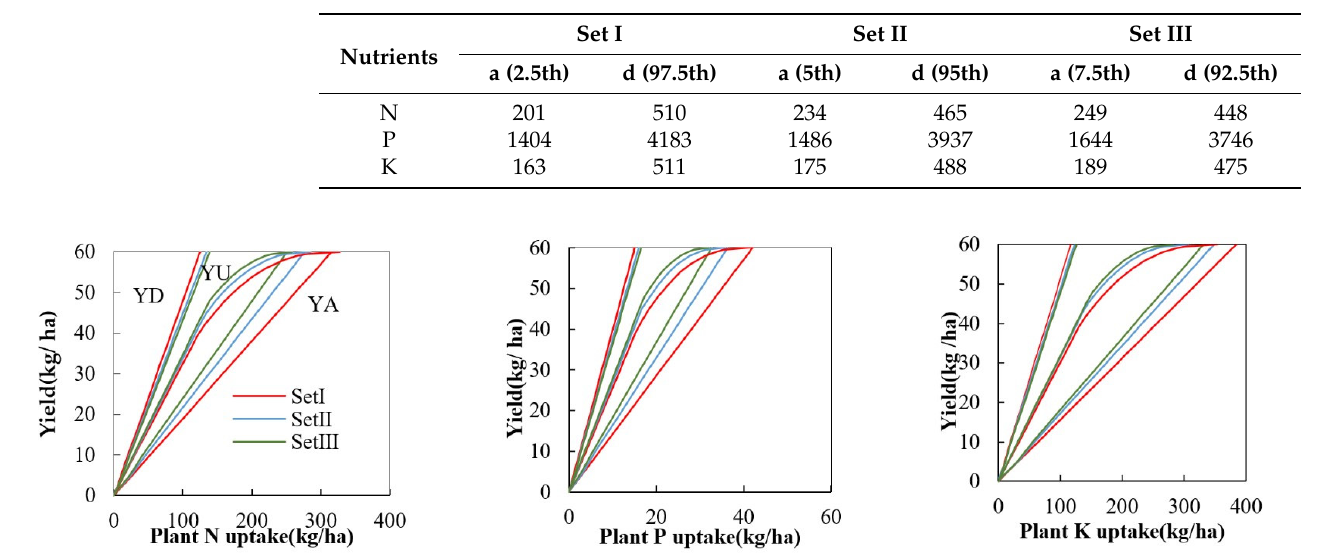
Figure 1. Relationship between melon yield and above ground nutrient absorption of N, P and K at three sets of constants a and d for all internal efficiency data (HI ≥ 0.4). YD, YA and YU represent maximum dilution, maximum accumulation and balanced uptake of N, P and K in plant dry matter, respectively. The potential yield was set at 60 t/ha.